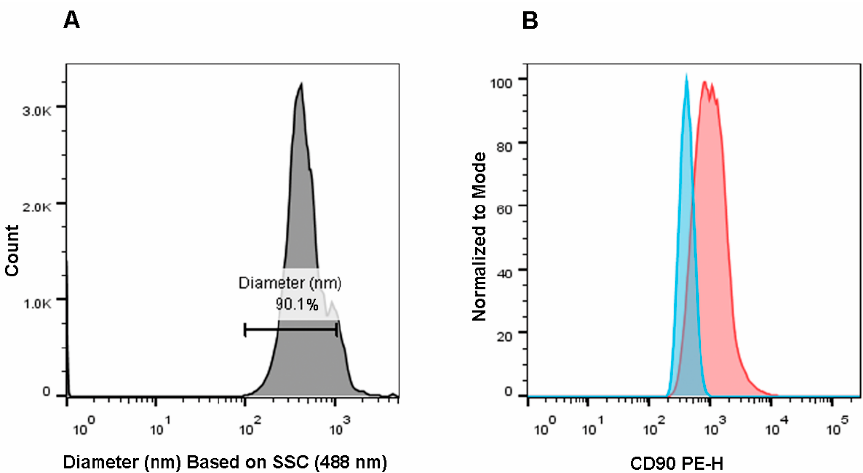
Figure 1. Mesenchymal stem cell (MSC)-derived extracellular vesicle (EV) analysis. ( A ) The size of events was obtained by transforming FSC files (.fcs) through the Rosetta Calibration system. The size of EVs was represented as a histogram and a gate covering EV dimensions was drawn (100–1000 nm). The percentage of EVs following in the EV diameter range is represented (90.1% of the acquired events). ( B ) The positivity to CD90 expression was verified: the histogram representing EVs stained by the anti-CD90 PE (Phycoerythrin, red) was overlaid to the histogram of the related isotype control (light blue).